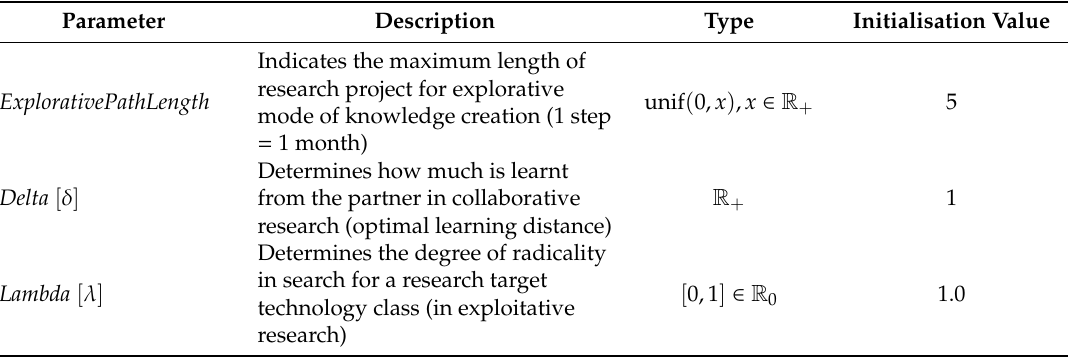
Table A2. Non-calibrated external system